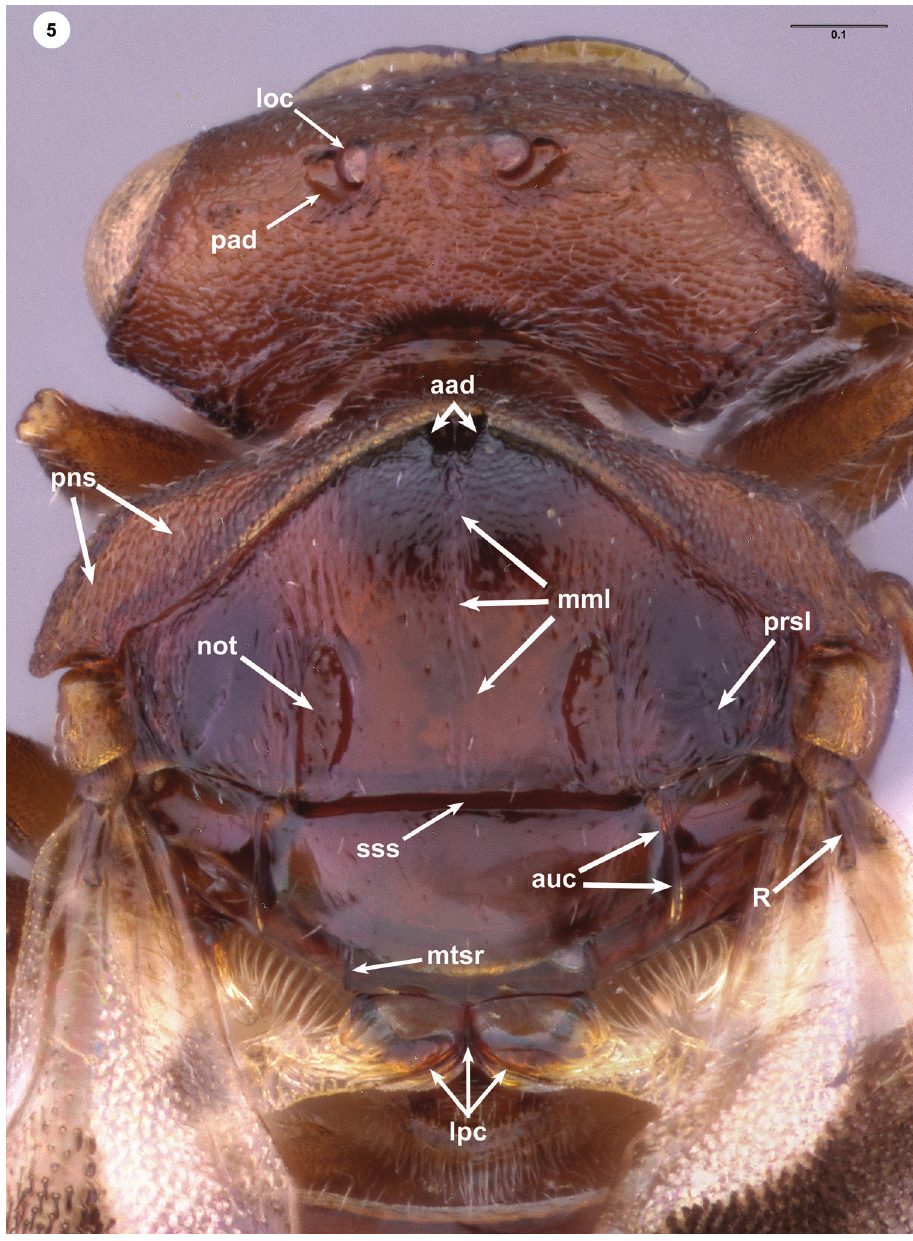
Figure 5. Pulchrisolia teras , male (CASENT 2043867), head, mesosoma, T1, dorsal view. Scale bar in